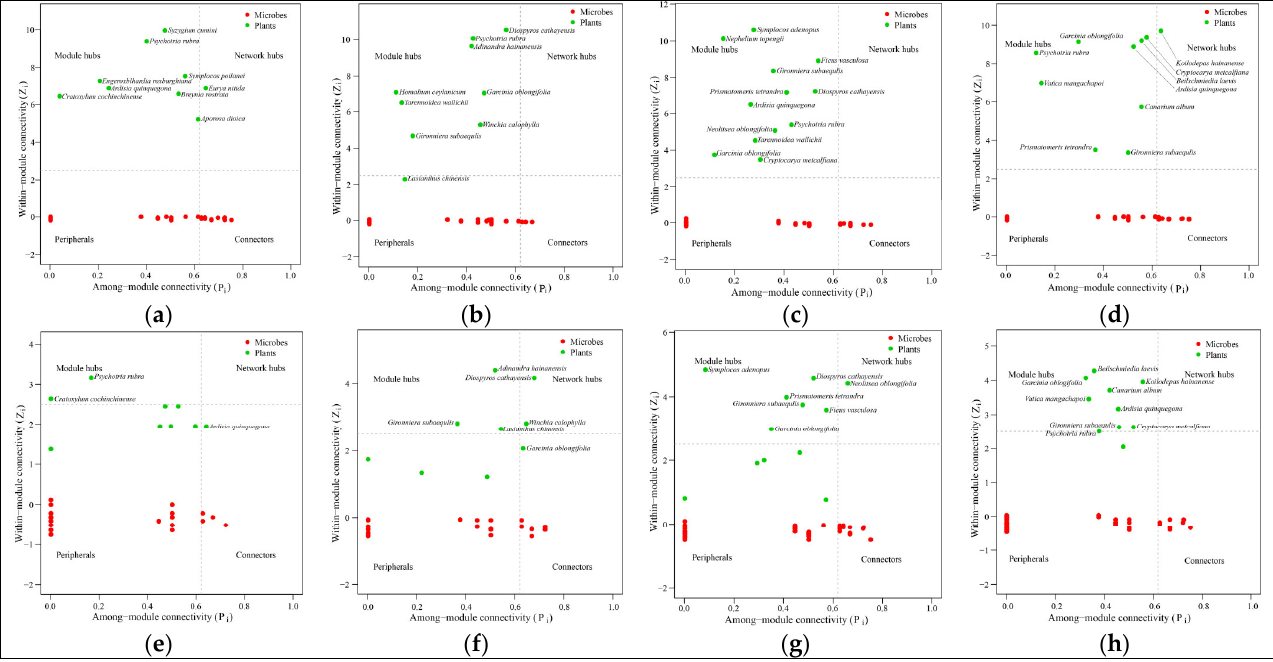
Figure 2. Modular roles of plant species and microorganisms based on Z-P value. ( a – d ) and ( e – h ) were Z-P plot of the plant–bacteria and plant–fungi networks of SB (slash-and-burn), CC (clear cutting), SL (selective cutting) and OG (old growth forests), respectively.